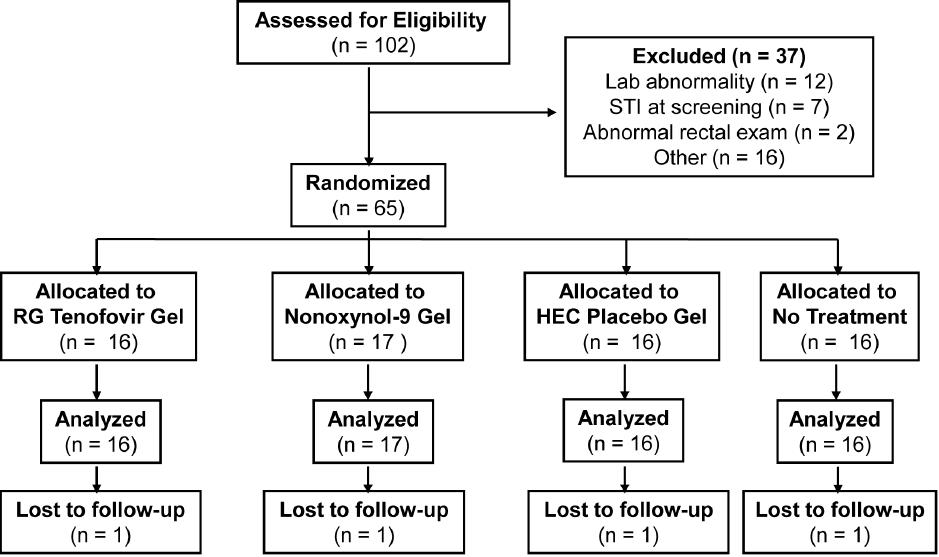
Figure 1. Flow diagram of participant progress through the MTN-007 study.